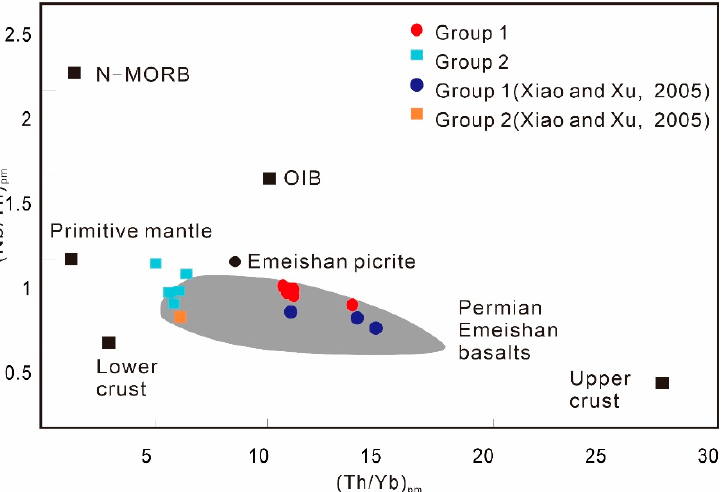
Figure 10. Crustal contamination discrimination diagrams for Dashibao basalts in the Xindianzi area. (Nb/Th) P vs. (Th/Yb) P plot is from [16].